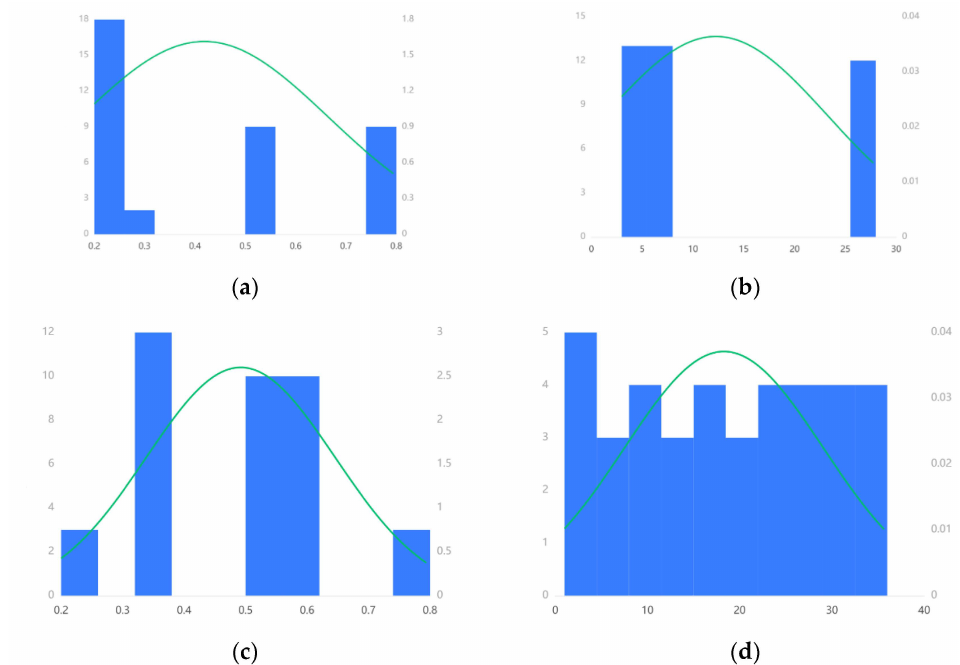
Figure 6. Database normality test histogram. ( a ) a-Normality test histogram. ( b ) d-Normality test histogram. ( c ) r-Normality test histogram. ( d ) f-Normality test